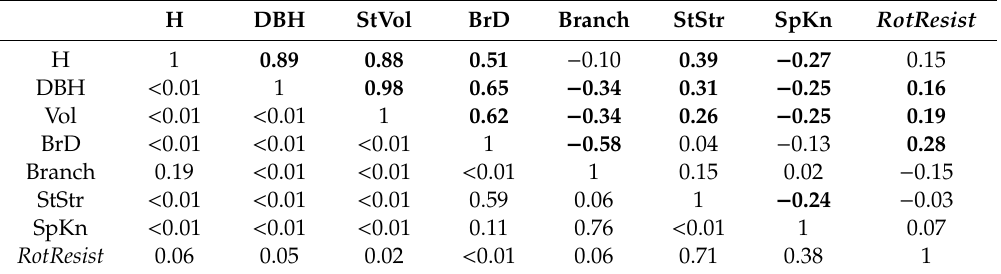
Table 2. Family mean breeding value correlations (significant correlations with p ≤ 0.05 in bold) in the upper diagonal part and their p- values in the lower diagonal part. Abbreviations: